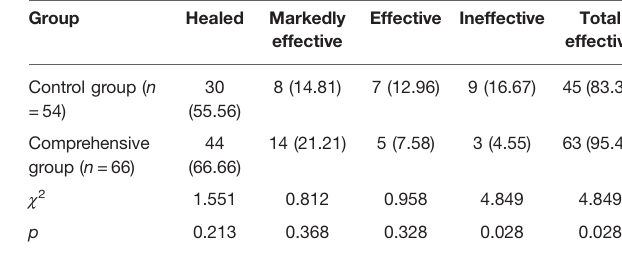
TABLE 3 | Clinical ef fi cacy analysis of 120